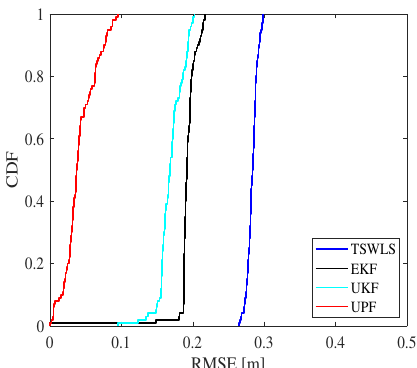
Figure 17. The CDF of RMSE for different algorithms in LOS scenario ( σ θ